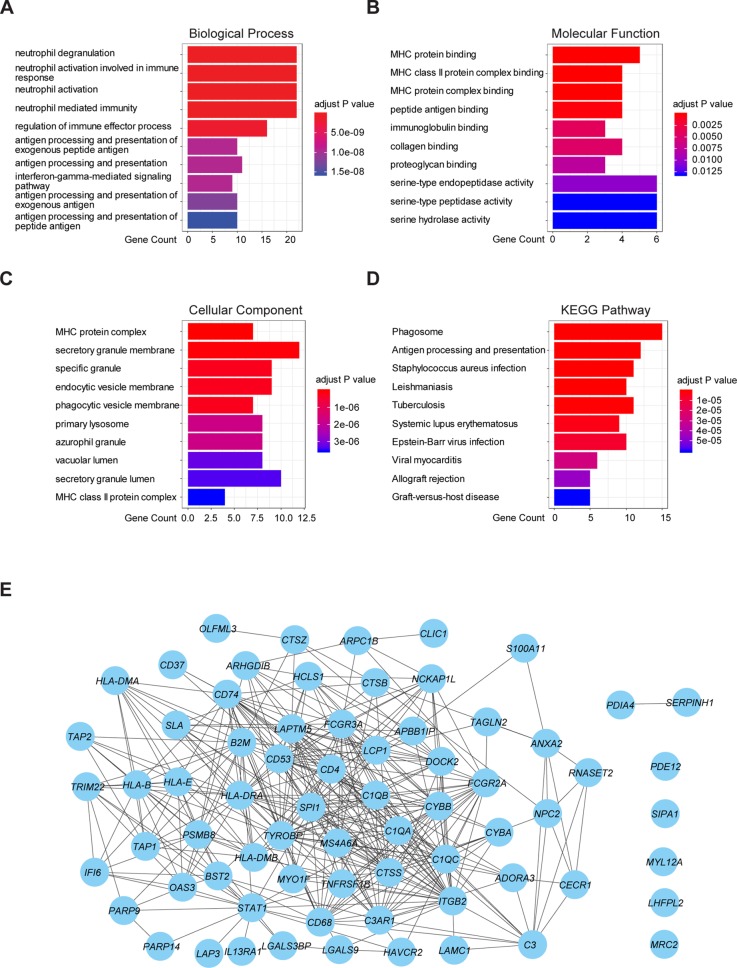
Functional enrichment analysis and PPI network of 70 prognostic genes in TCGA cohort. (A) The top 10 biological process terms of GO enrichment analysis of 70 prognostic genes. (B) The top 10 molecular function terms of GO enrichment analysis of 70 prognostic genes. (C) The top 10 cellular component terms of GO enrichment analysis of 70 prognostic genes. (D) KEGG pathway analysis for 70 prognostic genes and visualization of the top 10 terms. (E) PPI network of the 70 prognostic genes was visualized by Cytoscape.